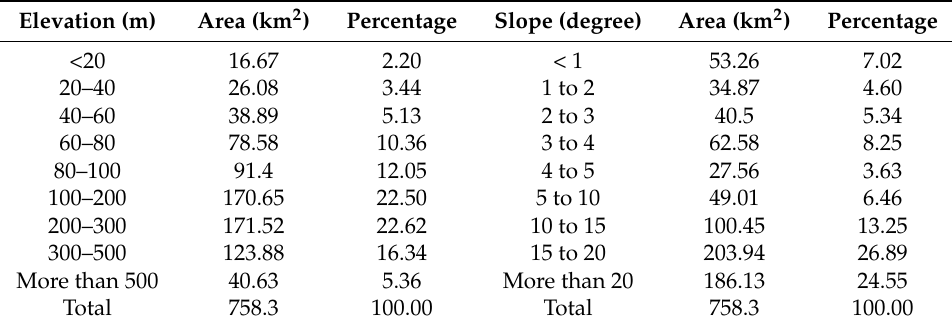
Table 4. Elevation and slope characteristics of the study area after